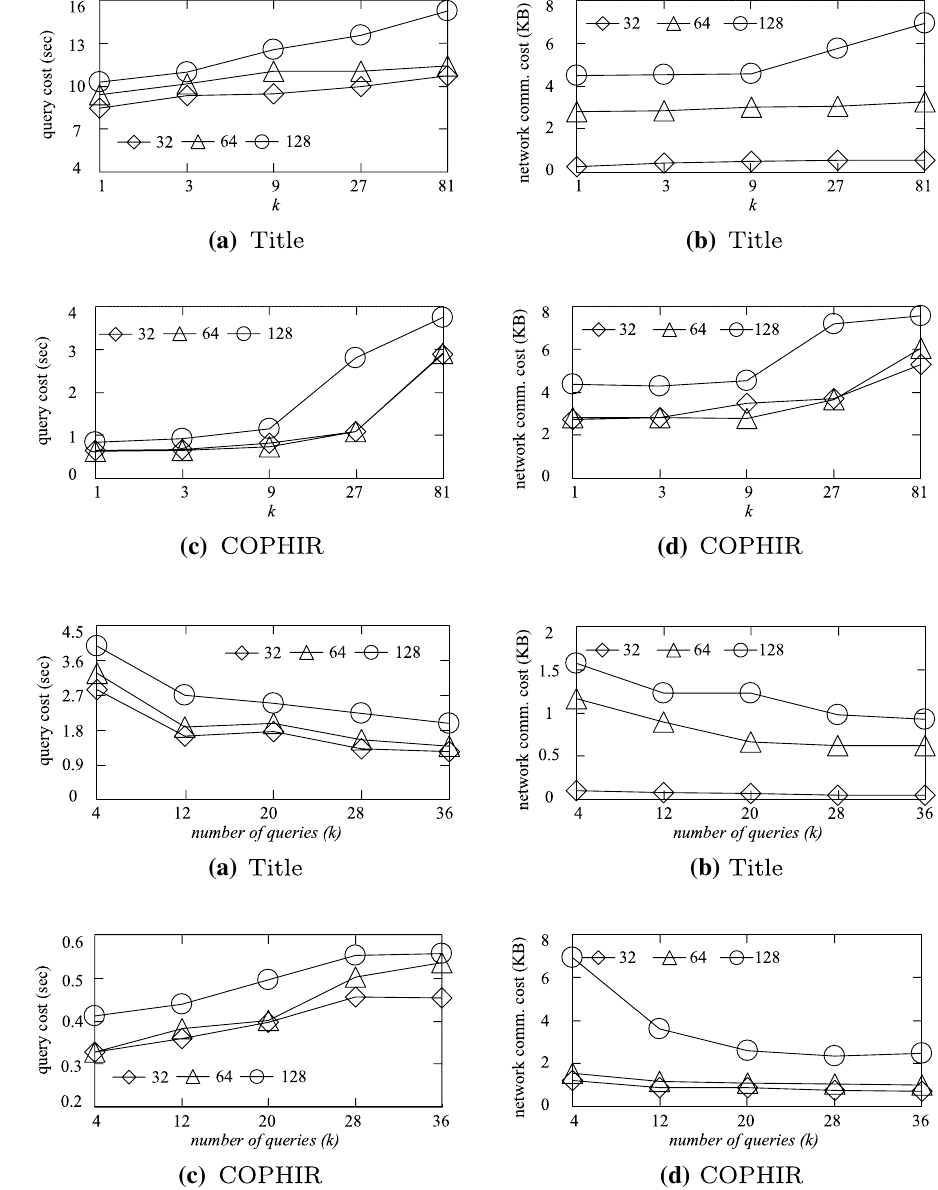
Fig. 9 Effect of number of